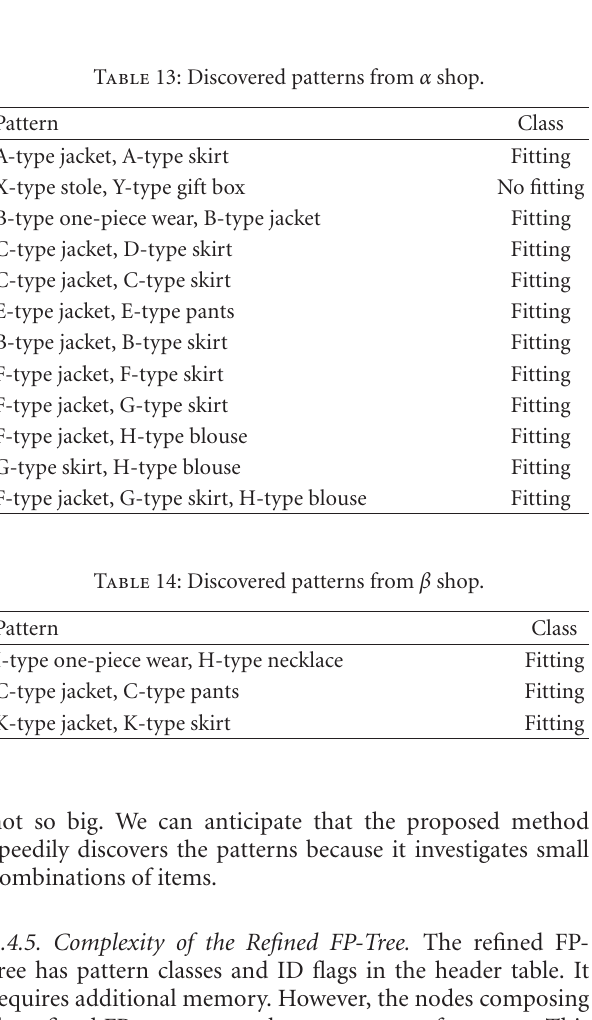
Figure 6: Experimental result in the case of the RFID data sets.